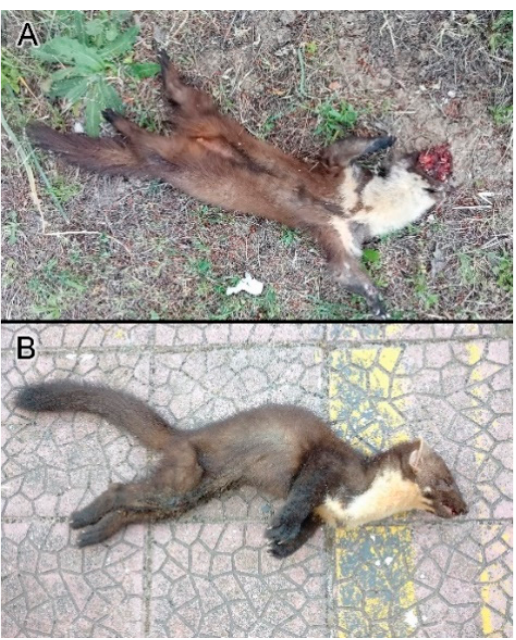
Figure A1. Road-killed European pine marten specimens collected in the frame of this work. ( A ) Specimen of Martes martes from “C.da Strasatto”; ( B ) Specimen of M. martes from “C.da Misericor- dia” (see Table 1 for further information).